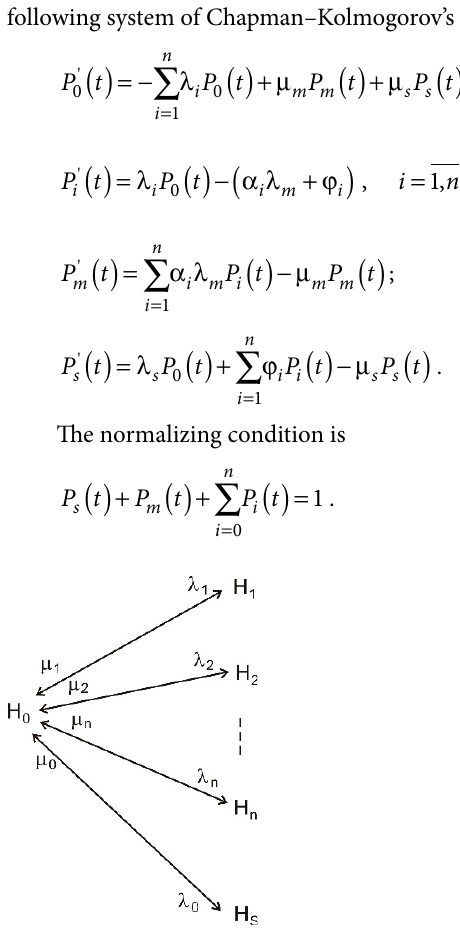
Fig. 14. Markov’s state transition diagram for A system with a continuously condition-based